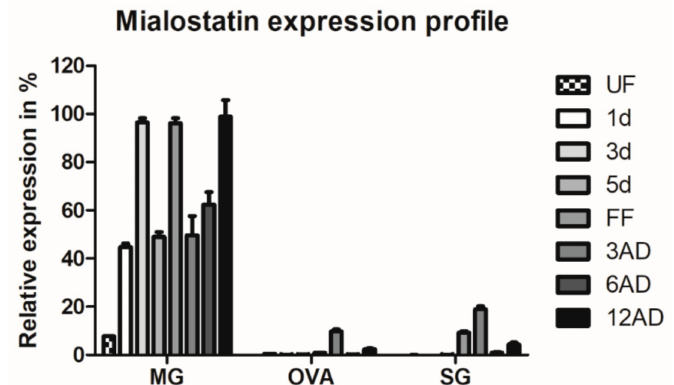
Figure 1. Mialostatin is predominantly produced in the tick midgut and its expression is upregulated by tick feeding. Expression maxima are prior to rapid engorgement, in fully fed females, and at two weeks post tick detachment from the host. Mialostatin expression was determined by quantitative PCR using cDNA templates prepared from a pool of three tissues from female ticks (MG—midgut, OVA—ovaries, SG—salivary glands). The qPCR output was normalized to the I. ricinus elongation factor 1 gene and compared across all values with the highest expression set to 100%. Data show an average of three biological replicates ± SEM. Categories: UF—unfed ticks; 1d, 3d, 5d—ticks after 1, 3, or 5 days of feeding; FF—fully fed ticks after 7–8 days of feeding; 3AD, 6AD, 12AD—ticks 3, 6, or 12 days after